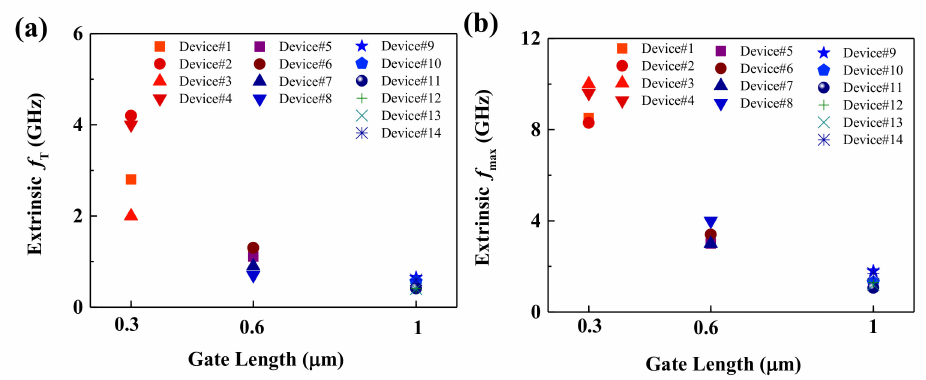
Figure 6. Extrinsic f T and f max of 14 flexible MoS 2 RF transistors. ( a ) Extrinsic f T as a function of gate length. ( b ) Extrinsic f max as a function of gate length.